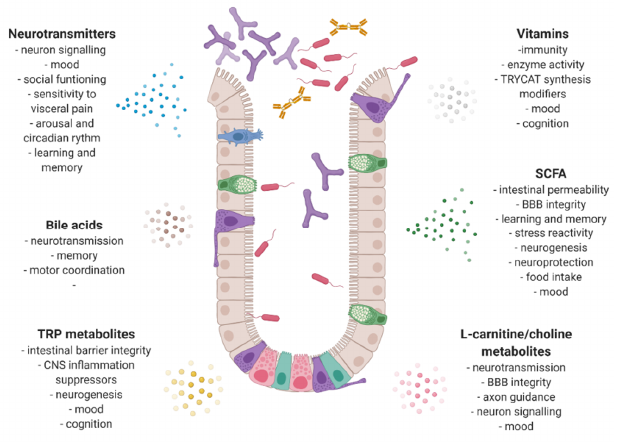
Figure 1. Gut microbiota metabolites and their neuroactive potential. SCFA—short chain fatty acid; TRYCAT—tryptophan catabolites; TRP— tryptophan; CNS—central nervous system; BBB—blood brain barrier. Created with